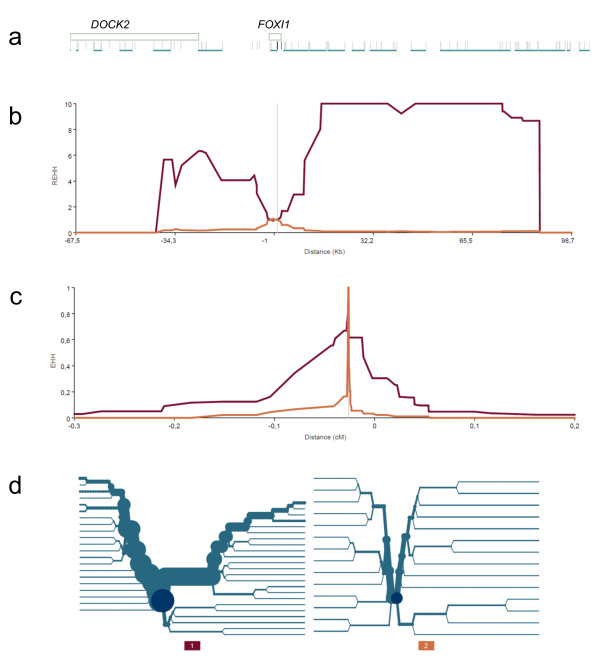
Decay of linkage disequilibrium around FOXI1 in Africans. (A). Genes and SNPs in the region. Boxes represent genes and vertical gray lines are SNPs. Underlined SNPs are those constituting core haplotypes. (B). Relative EHH over physical distance. The vertical grey line indicates the core region from which REHH is measured. Red and orange lines show REHH values at increasing distances from the core for the two main extended haplotypes. (C). Breakdown of EHH over genetic distance. The vertical grey line indicates the core region from which EHH is measured. Red and orange lines show EHH values at increasing distances from the core for the two main extended haplotypes (D) Haplotype bifurcation plots for each core haplotype. The dark blue circle in the center of each plot indicates the core and each node represents a SNP (and thus, a possible bifurcation). Blue lines indicate the observed haplotypes and the thickness of the branch is proportional to the haplotype frequency in the population.